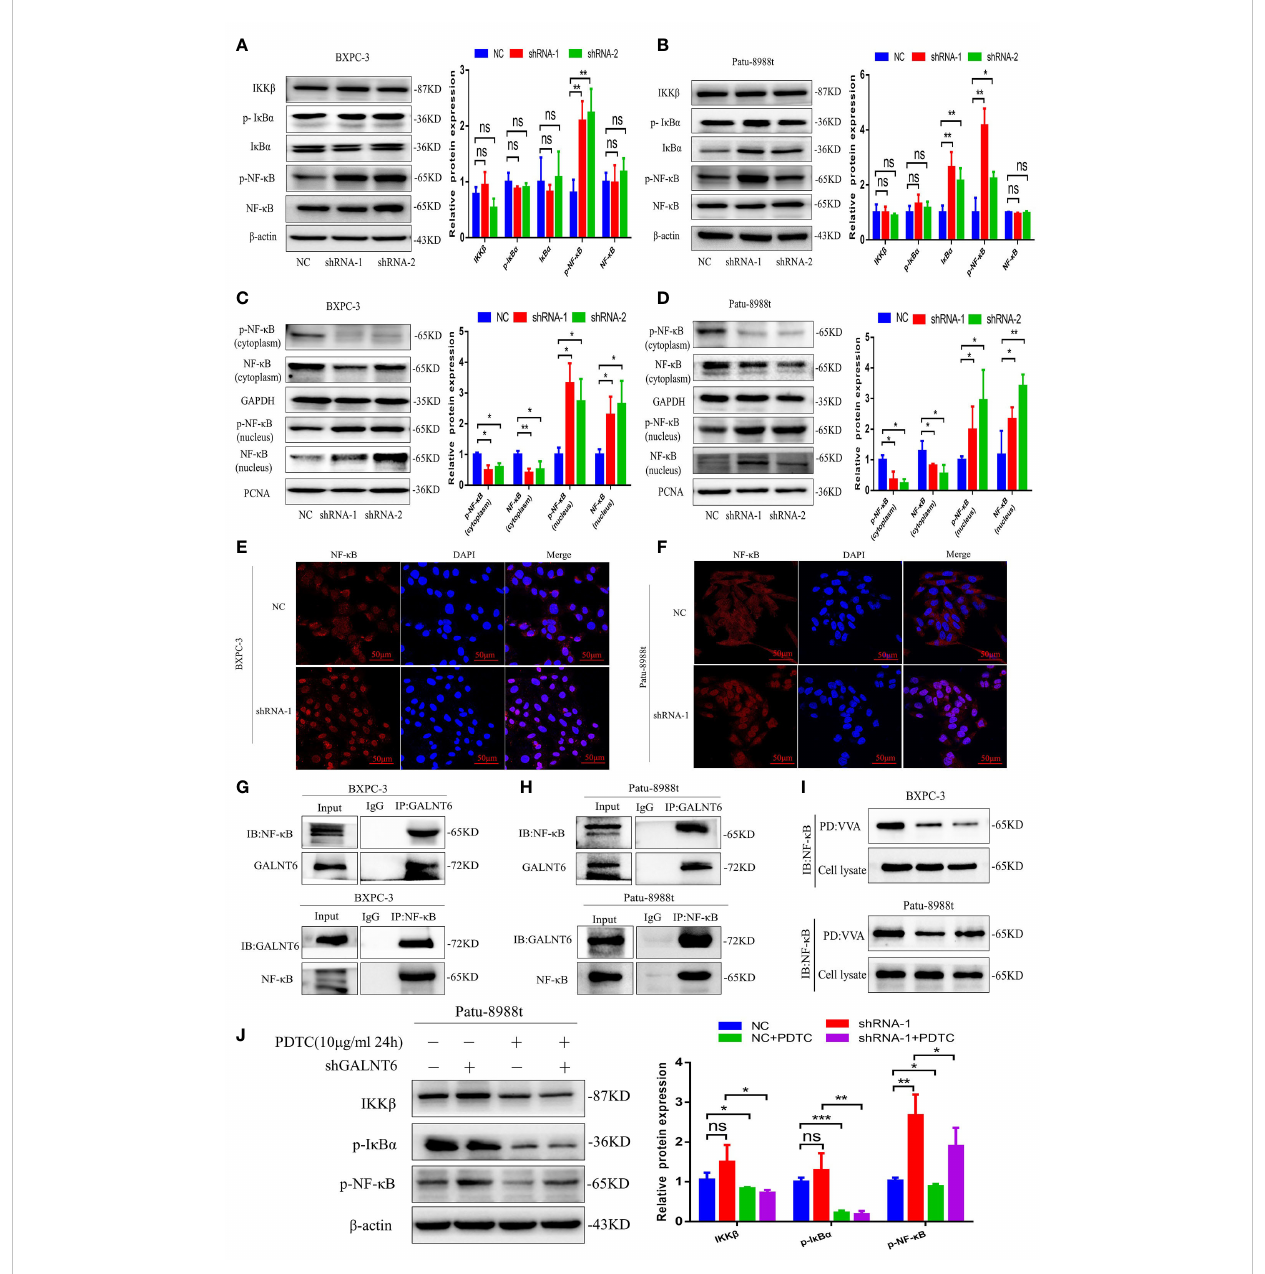
FIGURE 5 GALNT6 interacts with NF- k B. (A, B) Western blot was used to analyze the levels of IKK b , p-I k B a , I k B a , p-NF- k B and NF- k B in BXPC-3 and Patu- 8988t cells after knockdown of GALNT6. (C, D) Cell fractionation assay was used to detect the distribution of p-NF- k B and NF- k B in BXPC-3 and Patu-8988t cells after knockdown of GALNT6. (E, F) Immuno fl uorescence was used to detect the distribution of NF- k B in BXPC-3 and Patu-8988t cells after knockdown of GALNT6. (G, H) Co-IP assay was applied to determine the interaction of GALNT6 and NF- k B in BXPC-3 and Patu-8988t cells. (I) VVA pull-down assay was used to analysis glycosylation of NF- k B in BXPC-3 and Patu-8988t cells. (J) Western blot assay was used to detect the expression of IKK b , p-I k B a , p-NF- k B in Patu-8988t cells after GALNT6 knockdown or PDTC treatment. Each experiment was repeated at least three times independently, and the experimental data were expressed as mean standard deviation (X ± SD). ns, p >0.05; *p <0.05; **p <0.01; ***p